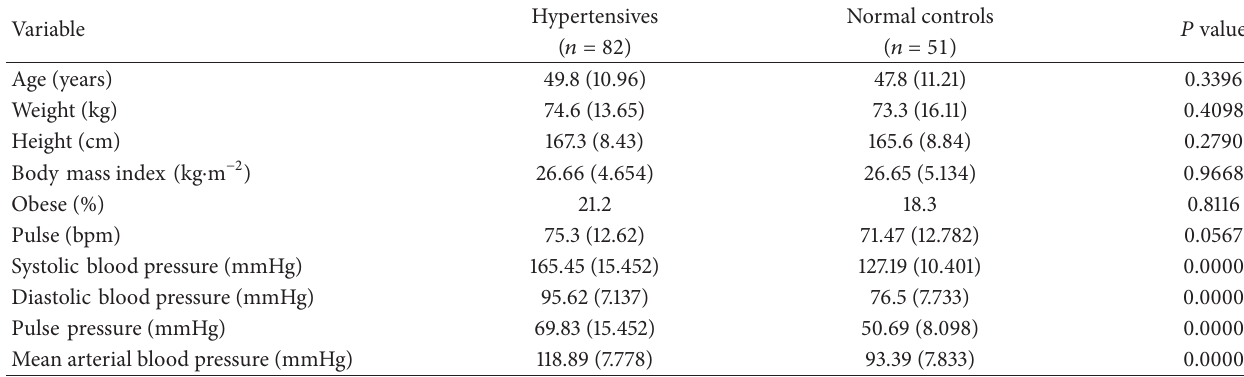
Table 1: Clinical characteristics of the subjects.